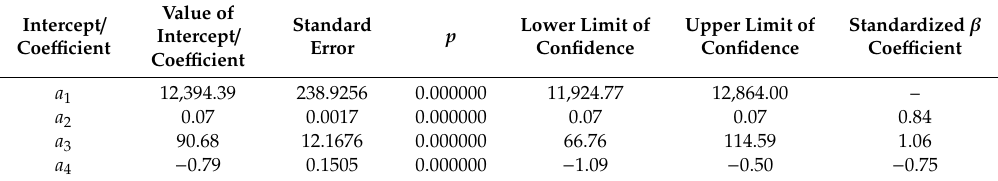
Table 8. Statistical evaluation of LHV model of torrefied pruned biomass (model 3).